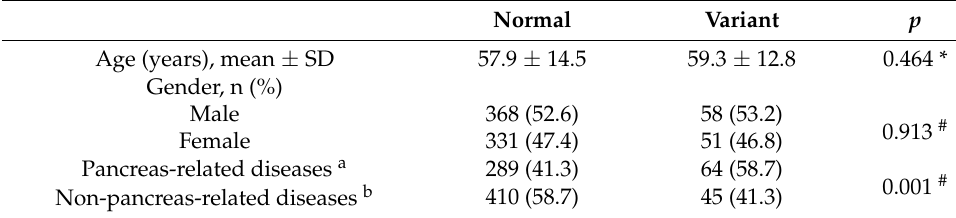
Table 1. Clinical Profile of the Participant.